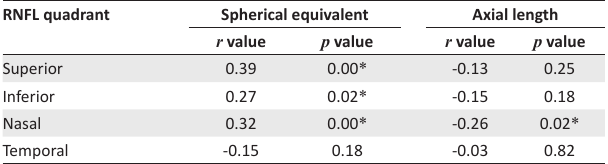
TABLE 4: Pearson correlation analyses between retinal nerve fibre layer thickness and spherical equivalent and axial length in total